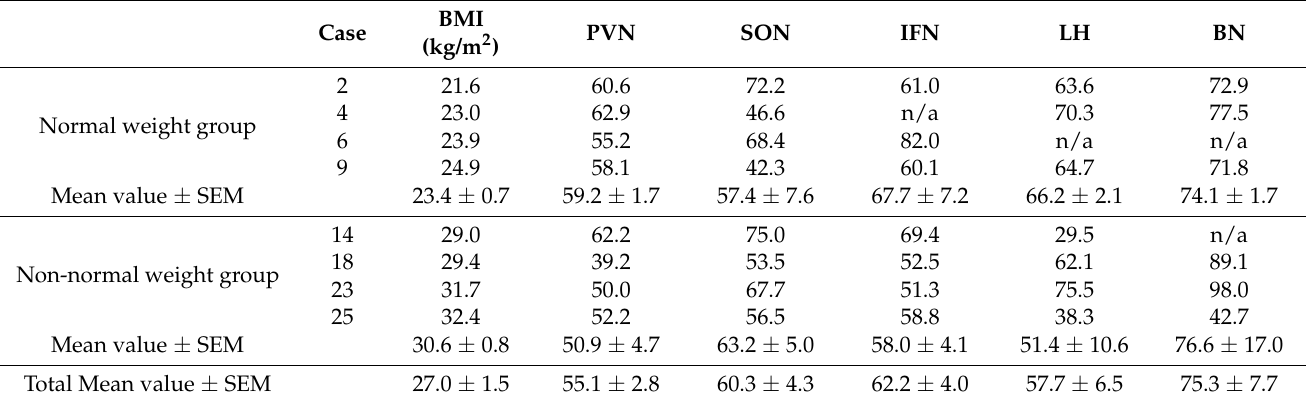
Table 5. Double immunofluorescence analysis of NUCB2/nesfatin-1-immunoreactive neurons colocalizing with GLP-1 receptor in human hypothalamus. Numbers present the percentage of NUCB2/nesfatin-1-immunoreactive neurons colocalized with GLP-1 receptor